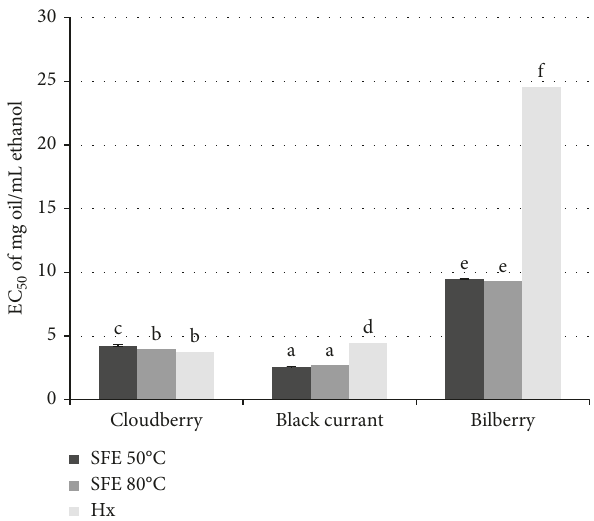
Figure 3: Values of EC 50 of cloudberry, black currant, and bilberry seed oils extracted by SFE at different temperatures and by hexane extraction. Results are mean values ± standard deviation of tripli- cates. Different letters above error bars denote significant difference ( p < 0 . 05 ) according to ANOVA followed by Tukey’s post hoc test.